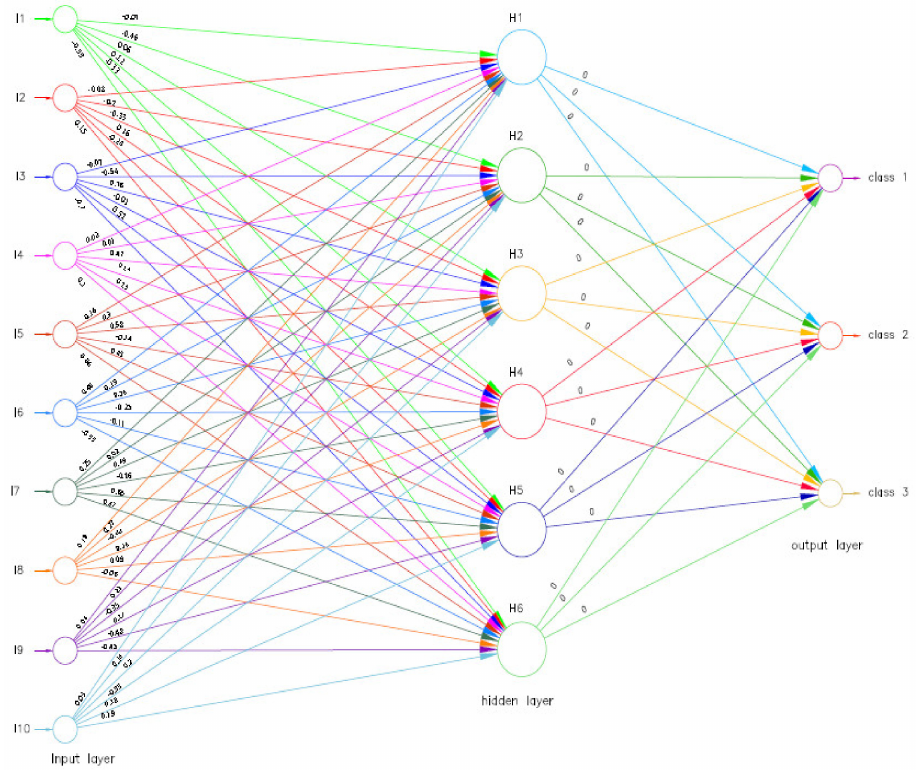
Figure 7. The neural network associated with the classification model (before